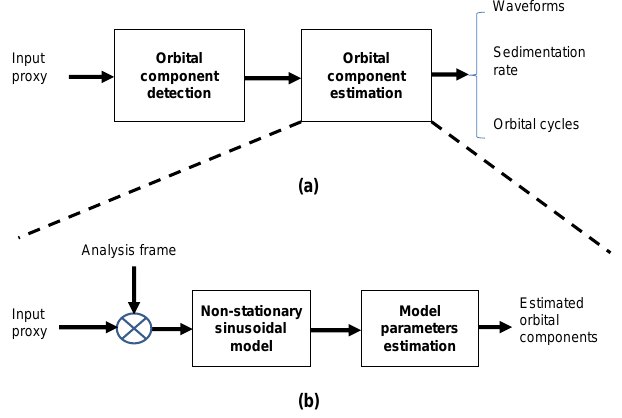
Figure 1. (a) Major steps in cyclostratigraphic signal processing. (b) The estimation step – a focus of the present